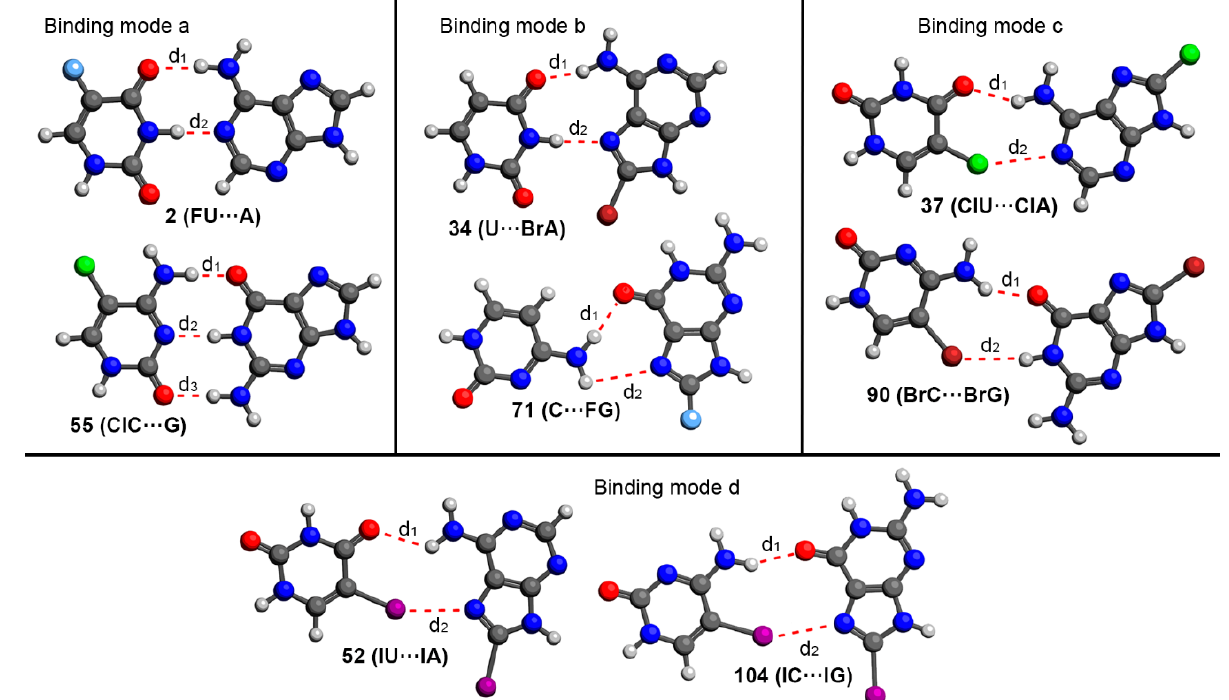
Figure 5. Optimized geometries (RI-MP2/def2-TZVP level of theory) of some representative com- plexes studied herein. Intermolecular distances (d 1 , d 2 and d 3 ) are gathered in Tables 3 and 4.